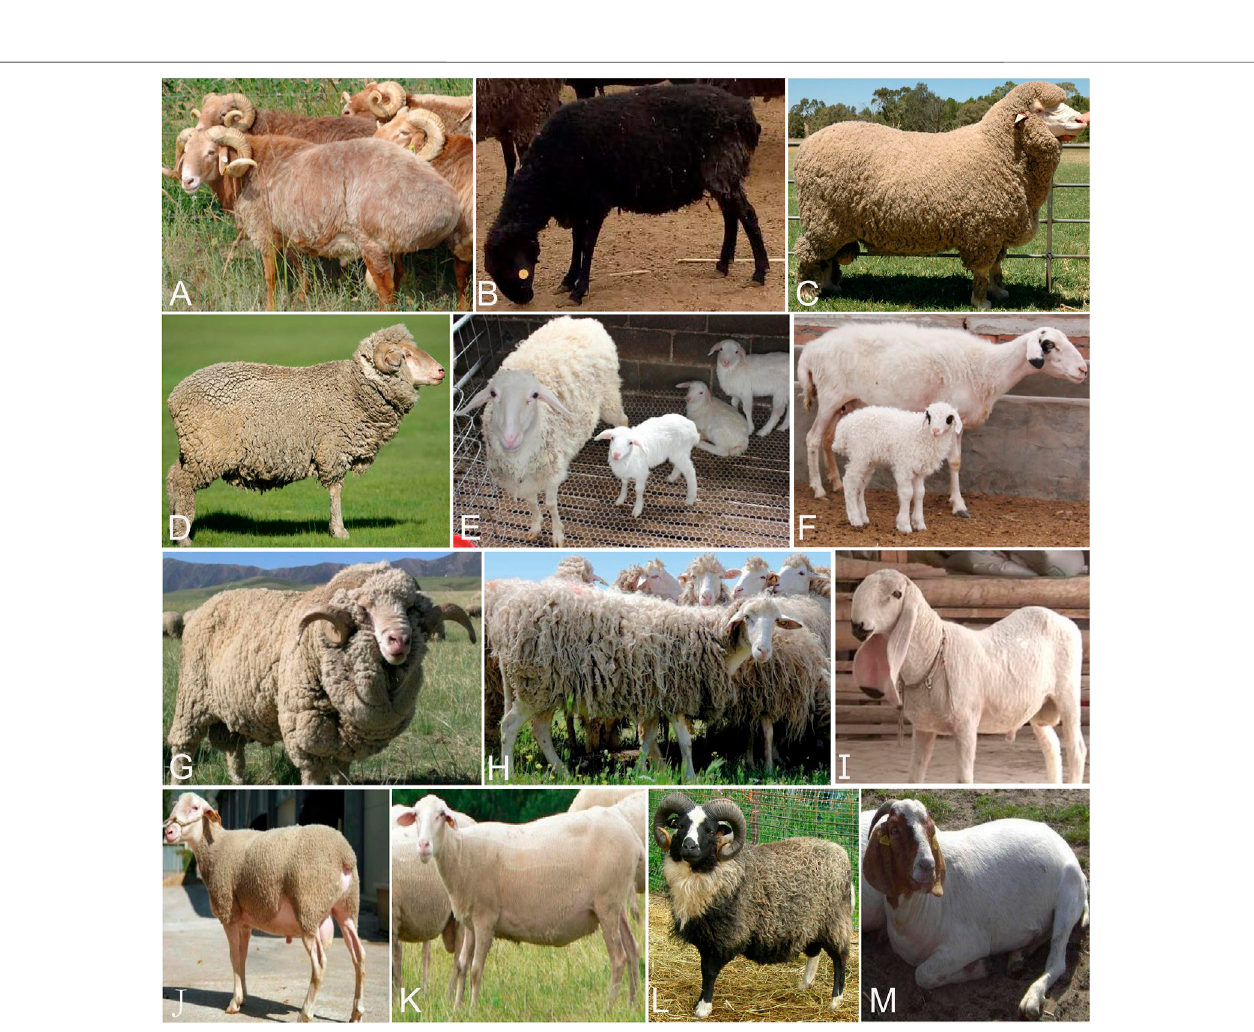
FIGURE 1 | Images of domestic sheep (A) Kazakh Edilbai sheep (B) Celle Black sheep (C) Polled Merino (D) Merino (E) Hu sheep (F) Tan sheep (G) Caucasian sheep (H) Altamuranasheep (I) JillWagnersheep (J) MeatLacaune (K) DairyLacaune (L) Shetland (M) EastFriesiansheep.Photocreditsareshowedinsupplementary table